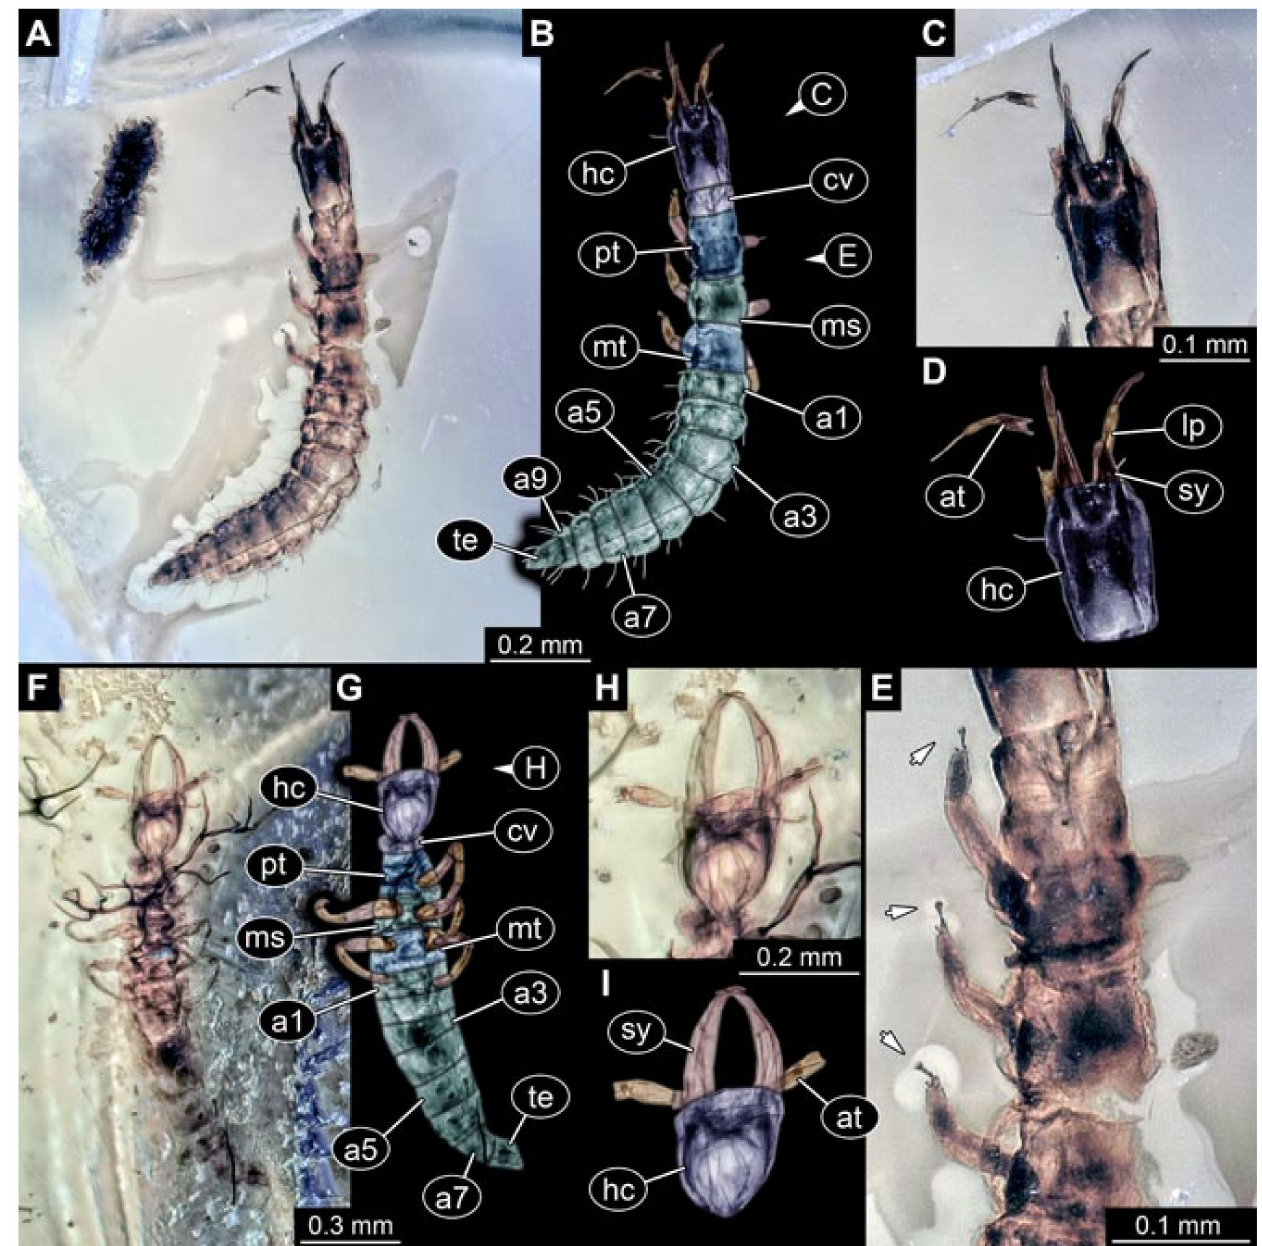
Figure 19. Specimens in Myanmar amber. ( A – E ) Specimen 5847 (PED 0769-1). ( A ) Dorsal view. ( B ) Dorsal view, colour- marked. ( C ) Close-up of head in dorsal view. ( D ) Close-up of head in dorsal view, colour-marked. ( E ) Close-up of trunk appendages with empodia (arrows) in dorsal view. ( F – I ) Specimen 5848 (PED 0769-2). ( F ) Ventral view. ( G ) Ventral view, colour-marked. ( H ) Close-up of head in ventral view. ( I ) Close-up of head in ventral view, colour-marked. Abbrevia- tions: a1–a9 = abdomen segment 1–9; at = antenna; cv = cervix; hc = head capsule; lp = labial palp; ms = mesothorax; mt = metathorax; pt = prothorax; sy = stylet; te = trunk